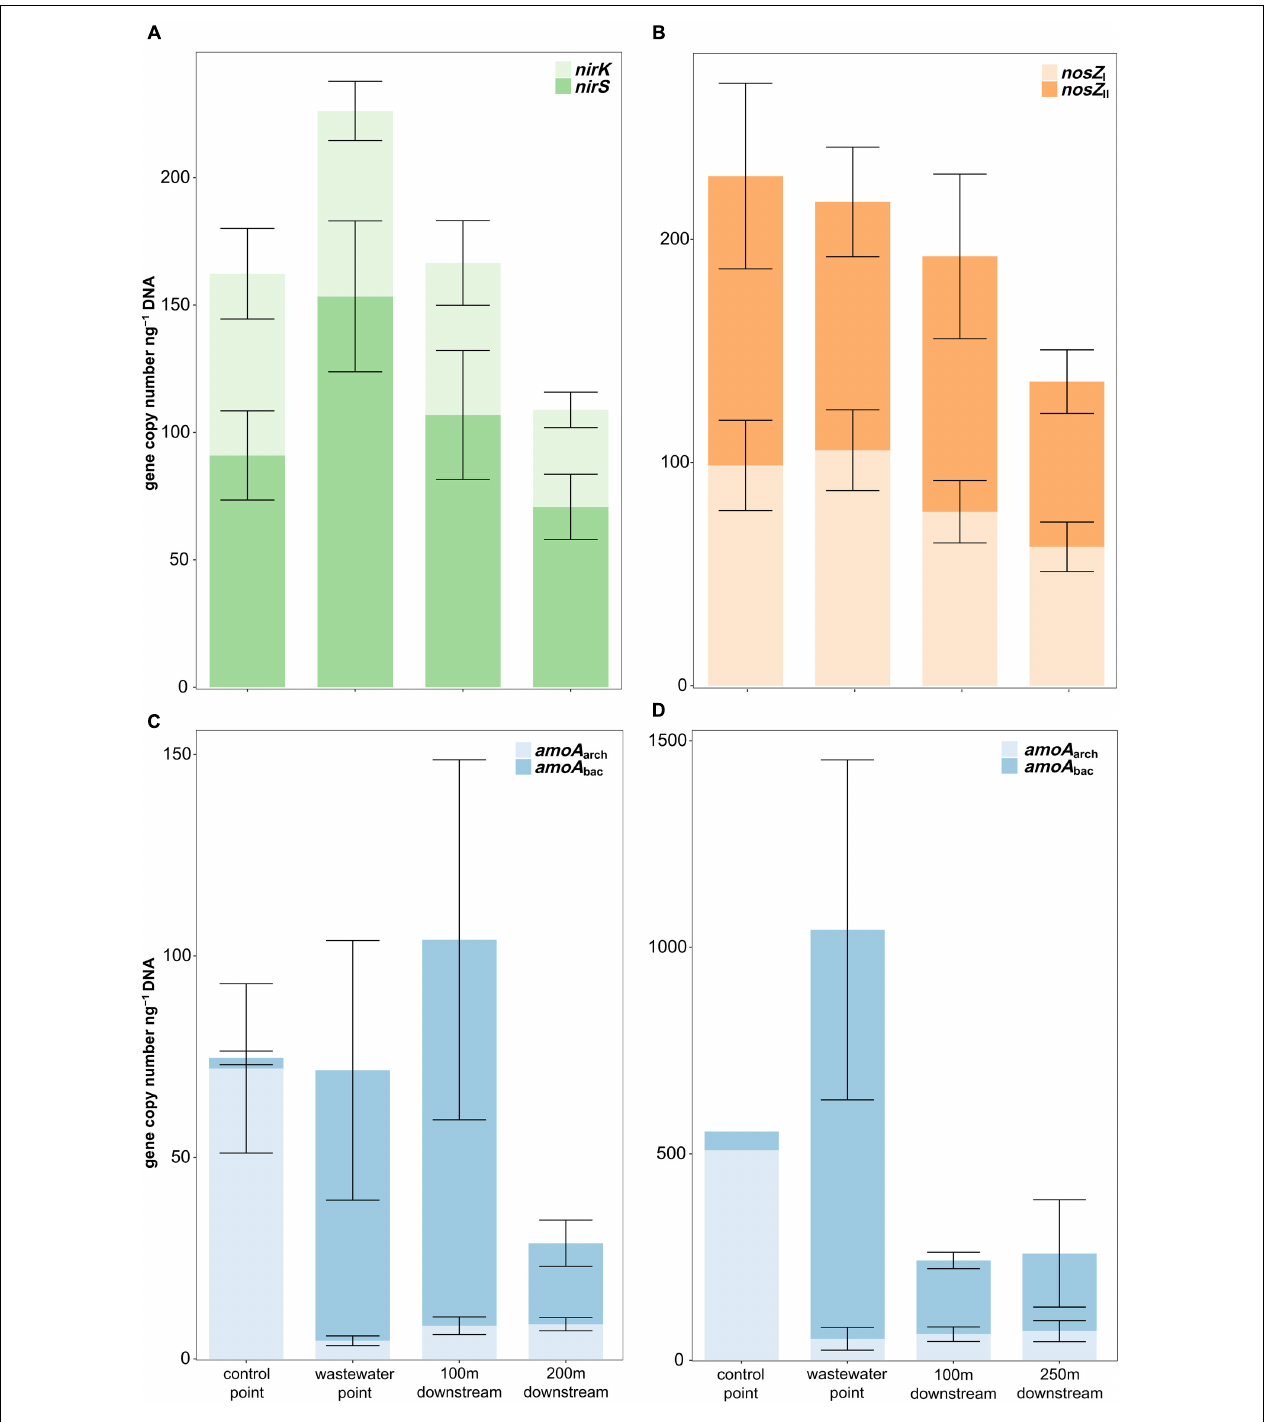
FIGURE 5 | Relative copy numbers of (A) nirS and nirK , (B) nosZ I and nosZ II , (C) amoA arch and amoA bac in Keuruu, and (D) amoA arch and amoA bac in